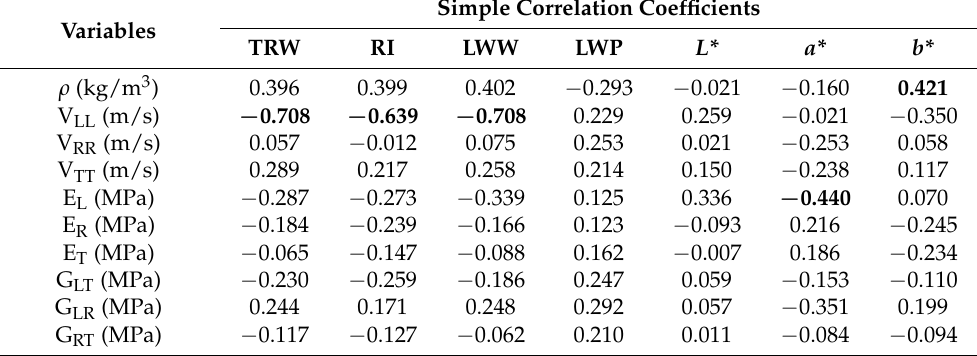
Table 7. Coefficient matrix of Spearman simple correlation between acoustic parameters and the physical and structural characteristics of the material (legend: values marked with bold are significant at p < 0.05).